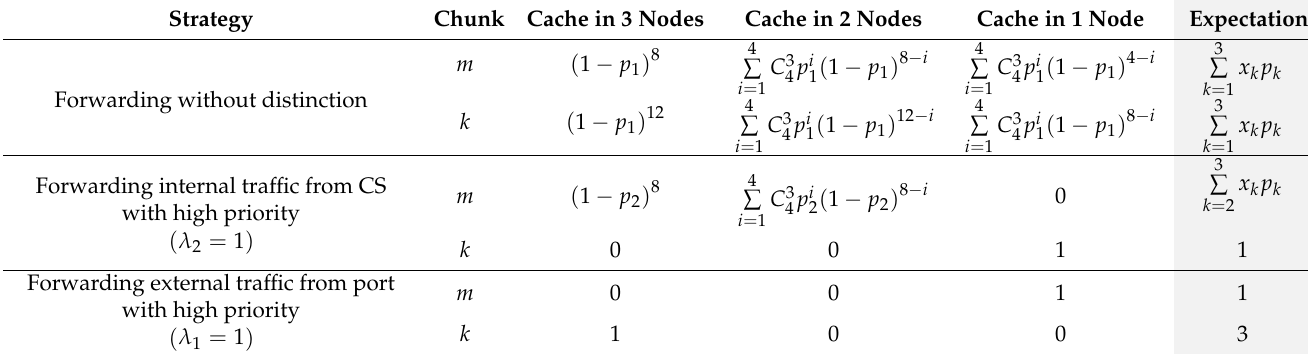
Table 1. The probability and expectation of the number of cache nodes for chunk m and k . Strategy Chunk Cache in 3 Nodes Cache in 2 Nodes Cache in 1 Node